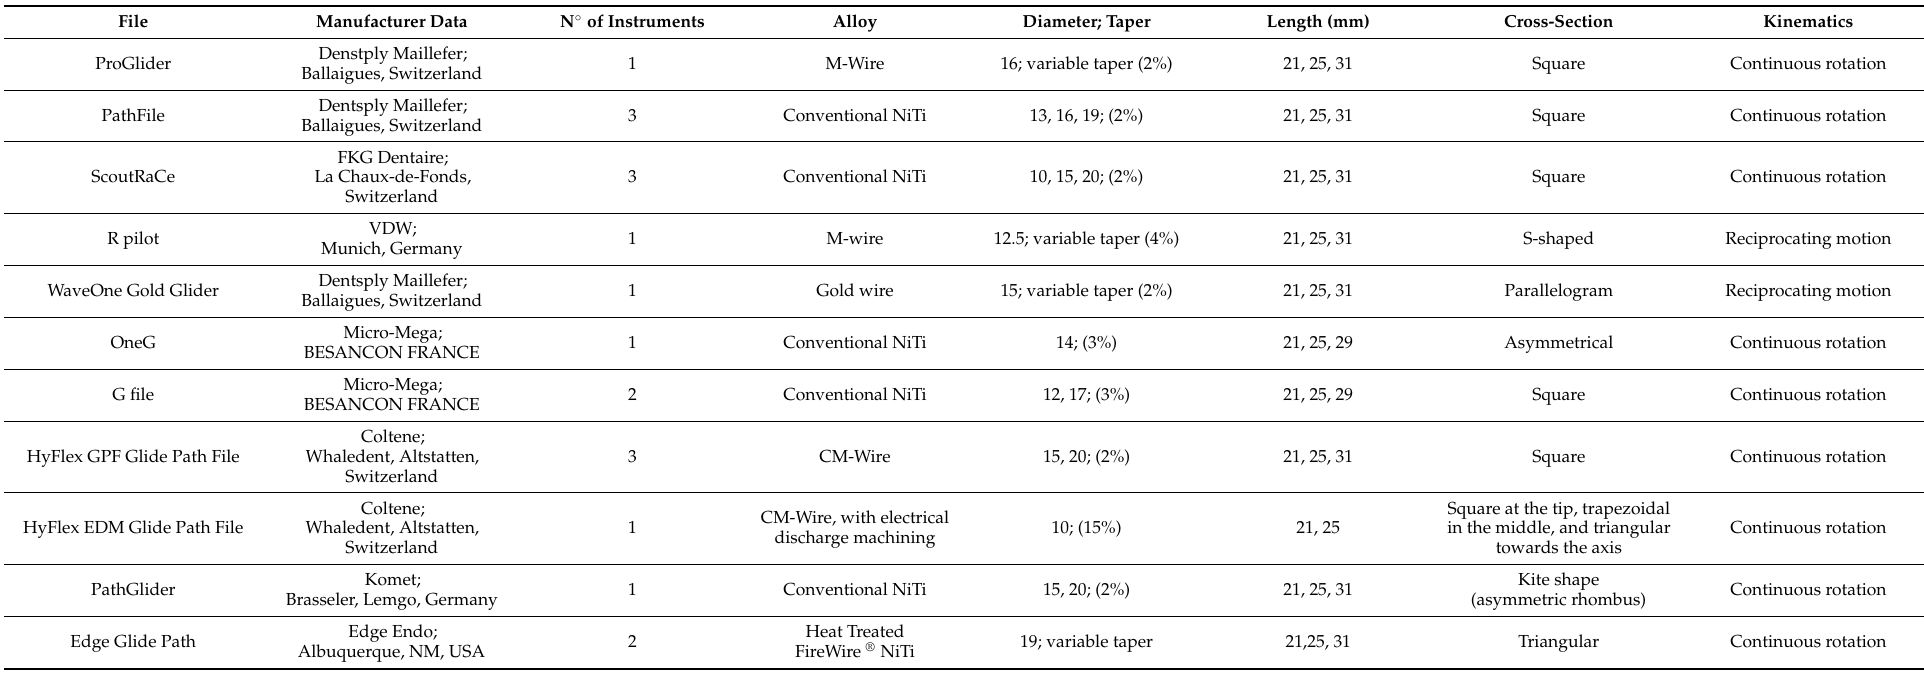
Table 1. List of commercially available rotary GP files included in this study.